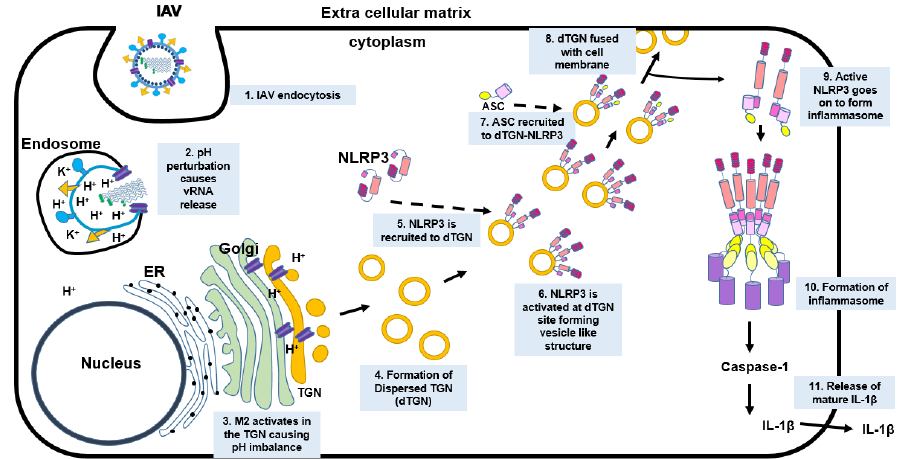
Figure 8. Schematic representation of the working model. Upon endocytosis of IAV, the pH of the endosome (pH 6) activates the IAV M2 ion channel protein leading to the release of vRNP into the cytoplasm. The vRNP then translocates into the nucleus to undergo transcription and translation. The newly translated M2 protein travels from the ER through the Golgi apparatus and reaches TGN. The pH of the TGN (pH 6) causes a pH disparity in the pH-sensitive organelle which leads to the dispersion of the TGN (dTGN). The NLRP3 molecules then travel to the newly formed dTGN where the NLRP3 undergoes conformational changes, oligomerization, and becomes active. The ASC molecule is then recruited to the site of dTGN-NLRP3, where the NLRP3 binds to ASC from its PYD domain. The NLRP3–ASC complex then leaves the dTGN and goes on to form the inflammasome, while the dTGN goes on to fuse with the cell membrane. The active NLRP3 inflammasome then leads to the production of active caspase-1 which then converts pro-IL-1 β to mature IL-1 β . The mature IL-1 β is then released into the extracellular matrix, which then signals other immune cells to travel to the site of